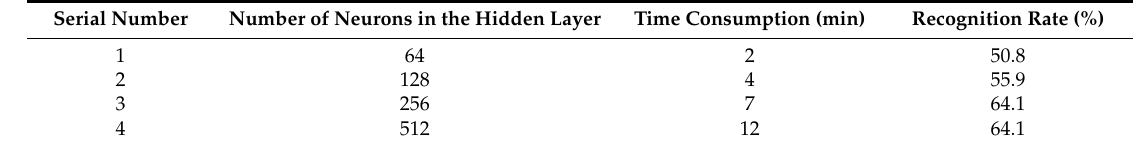
Table 2. Hyper parametric tuning of the BiLSTM Model.